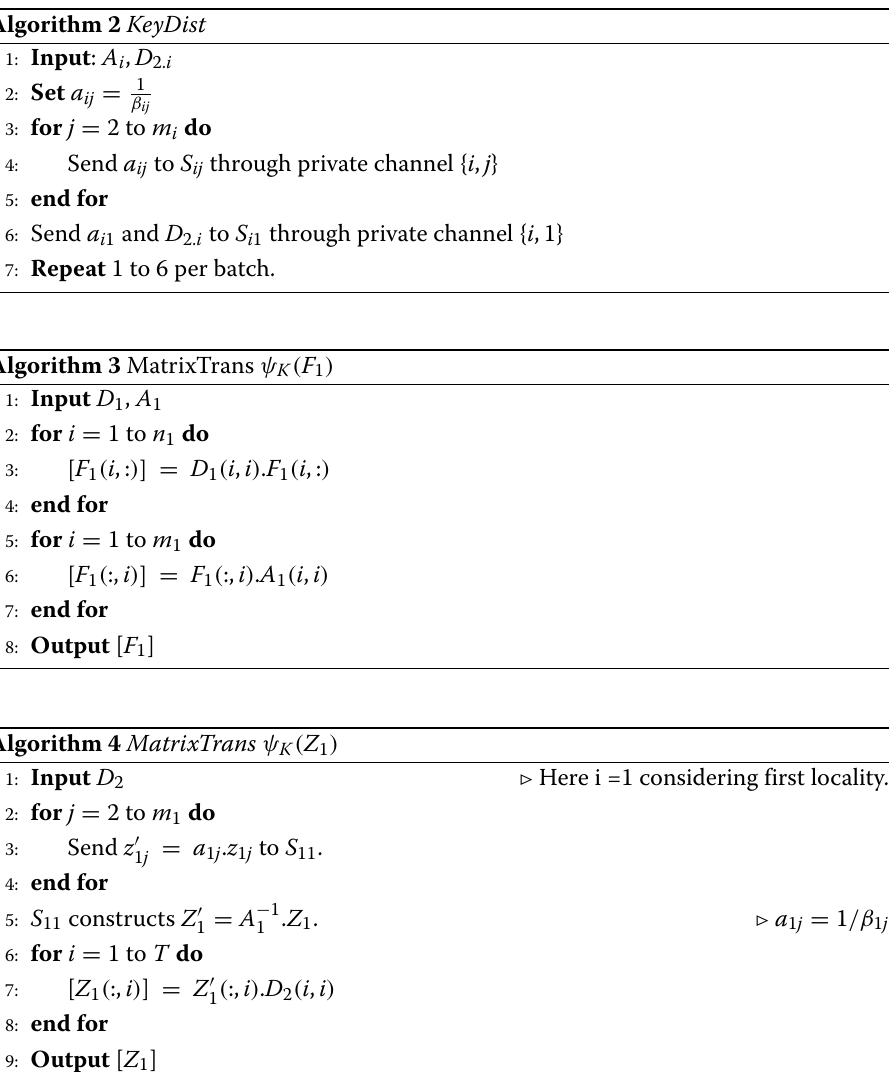
Algorithm 5. This algorithm performs the computation on the cloud server. It computes